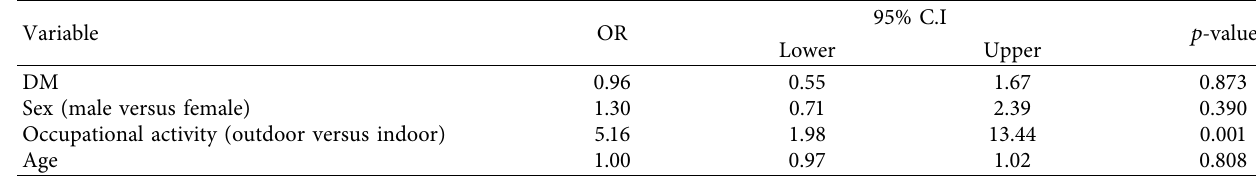
Table 3: Multivariate analysis of factors associated with